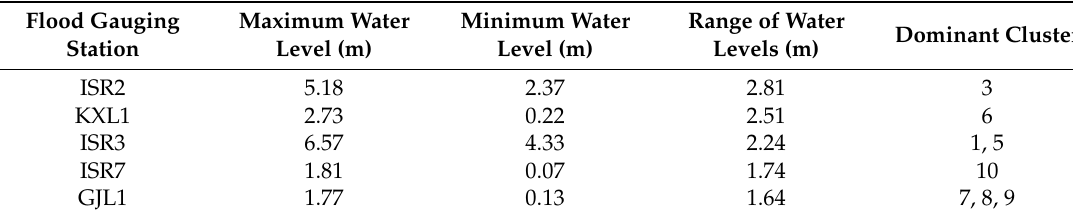
Table 3. Hydrologic descriptions and dominant clusters for flood gauging stations.